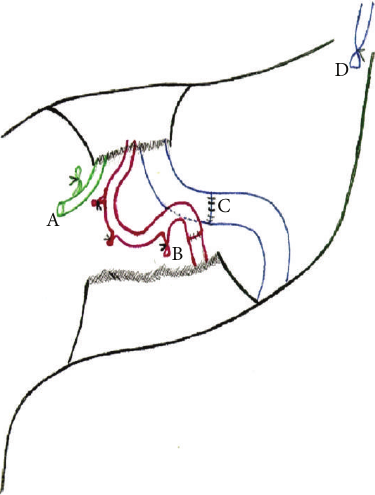
Figure 2: A: donor common bile duct; B: donor-recipient arterial anastomosis; C: gastroportal anastomosis; D: left gastric vein distal neck.